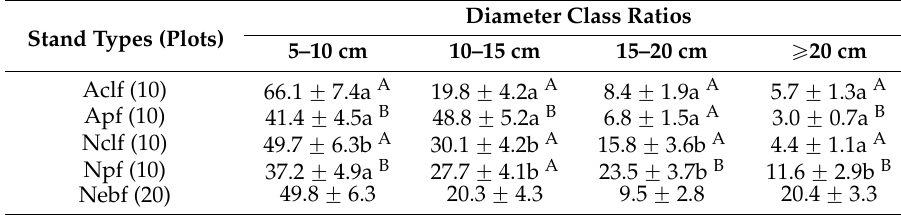
Table A1. Standing trees ratios (%) of diameter class in artificial and natural forests.